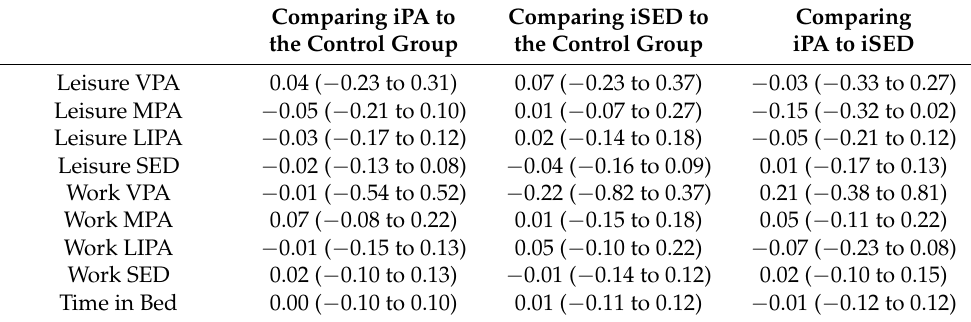
Table A2. Differences in change from baseline to follow-up between groups for domain-specific movement behaviors (estimates with 95% CI), based on the linear mixed models. Comparing iPA to Comparing iSED to Comparing the Control Group the Control Group